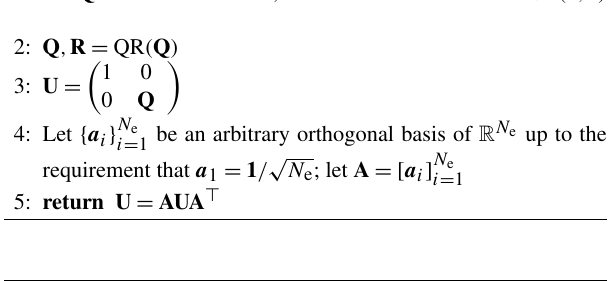
Algorithm A3 Ensemble update (EU).